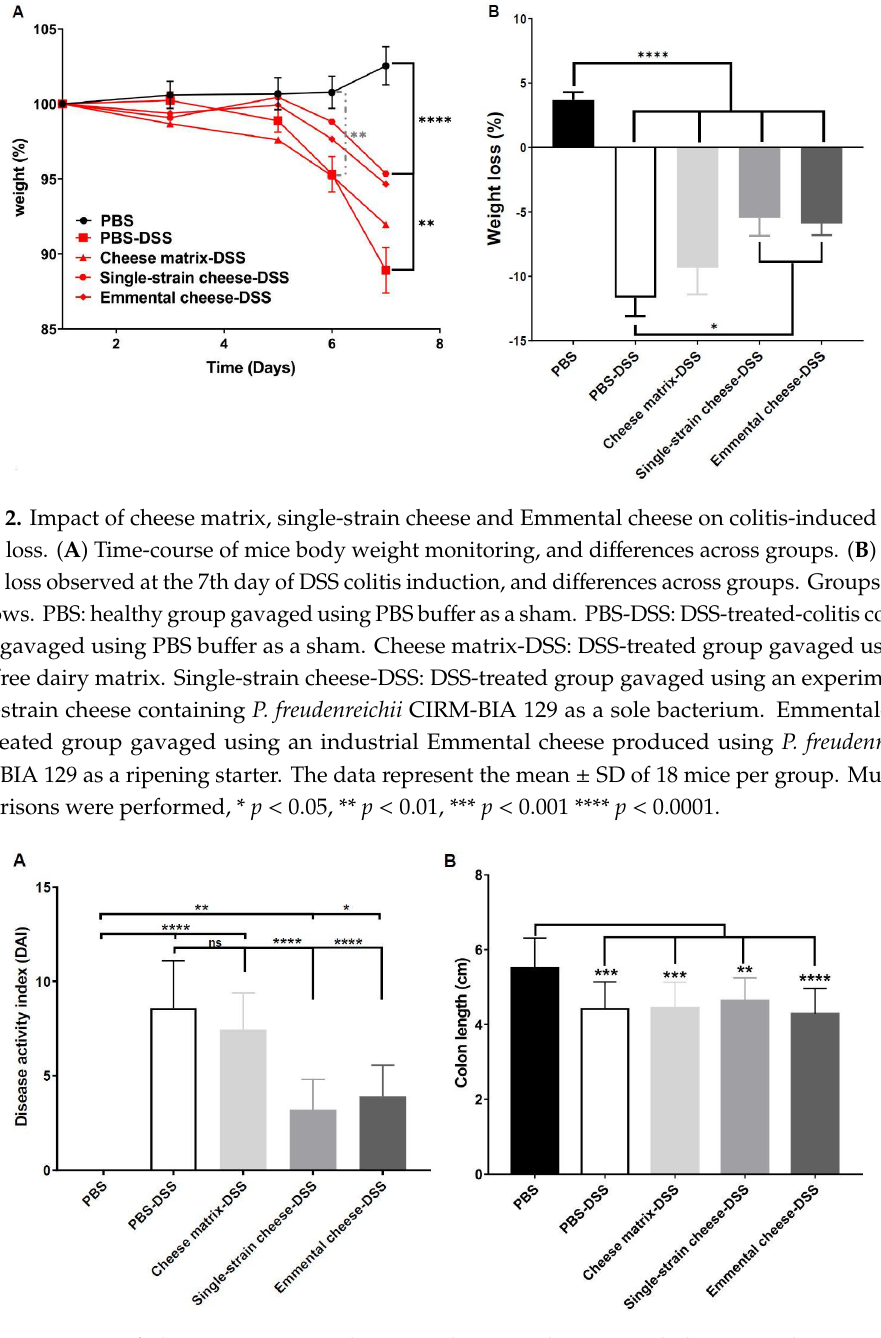
Figure 3. Impact of cheese matrix, single-strain cheese and Emmental cheese on the severity of DSS-induced colitis. Seven days after colitis induction, disease activity index (DAI) ( A ) and Colon length ( B ) were determined. Groups were as follows. PBS: healthy group gavaged using PBS bu ff er as a sham. PBS-DSS: DSS-treated-colitis control group gavaged using PBS bu ff er as a sham. Cheese matrix-DSS: DSS-treated group gavaged using a germ-free dairy matrix. Single-strain cheese-DSS: DSS-treated group gavaged using an experimental single-strain cheese containing P. freudenreichii CIRM-BIA 129 as a sole bacterium. Emmental-DSS: DSS-treated group gavaged using an industrial Emmental cheese produced using P. freudenreichii CIRM-BIA 129 as a ripening starter. The data represent the mean ± SD of 18 mice per group. Multiple comparisons were performed, * p < 0.05, ** p < 0.01, *** p < 0.001 **** p <